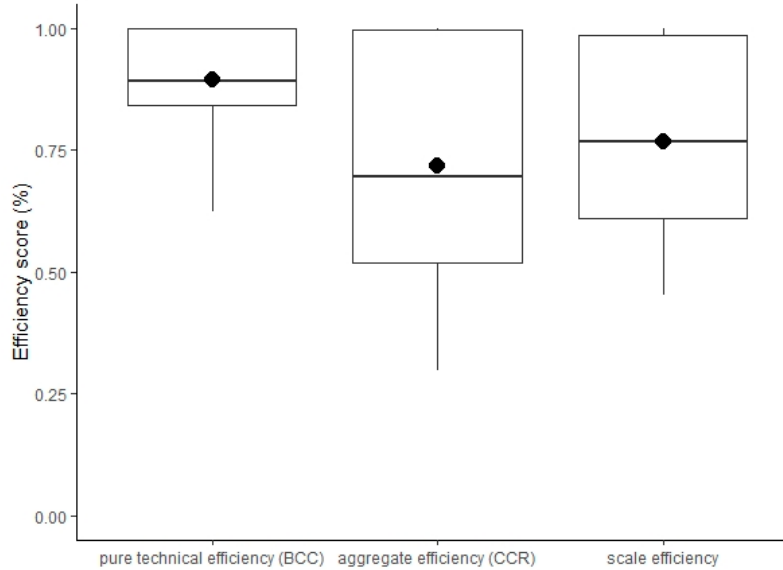
Figure 4. Efficiency scores of the DMUs that were examined. Black dots present the mean value. The aggregate or overall efficiency (CCR) had an average ( ± SD) of 72% ± 23% (median: 69%). DMUs deemed efficient (100%) totaled 13, representing 26% of the sample, while inefficient DMUs had efficiency values ranging between 97% and 30%.